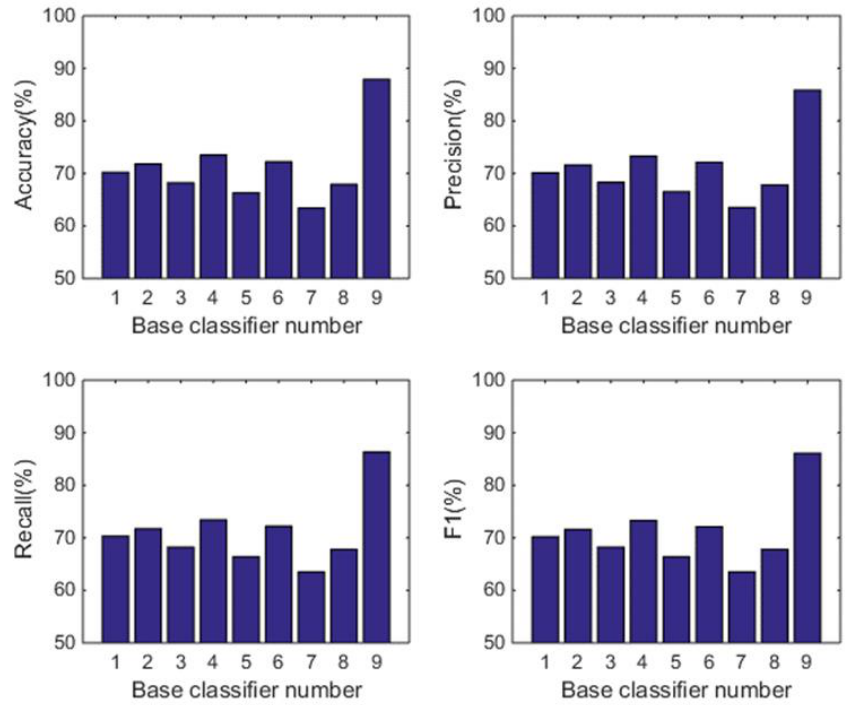
Figure 6. Performance comparison between base classifiers (1–8) and our fused classifier (9) for subject 3 in OPPORTUNITY dataset.